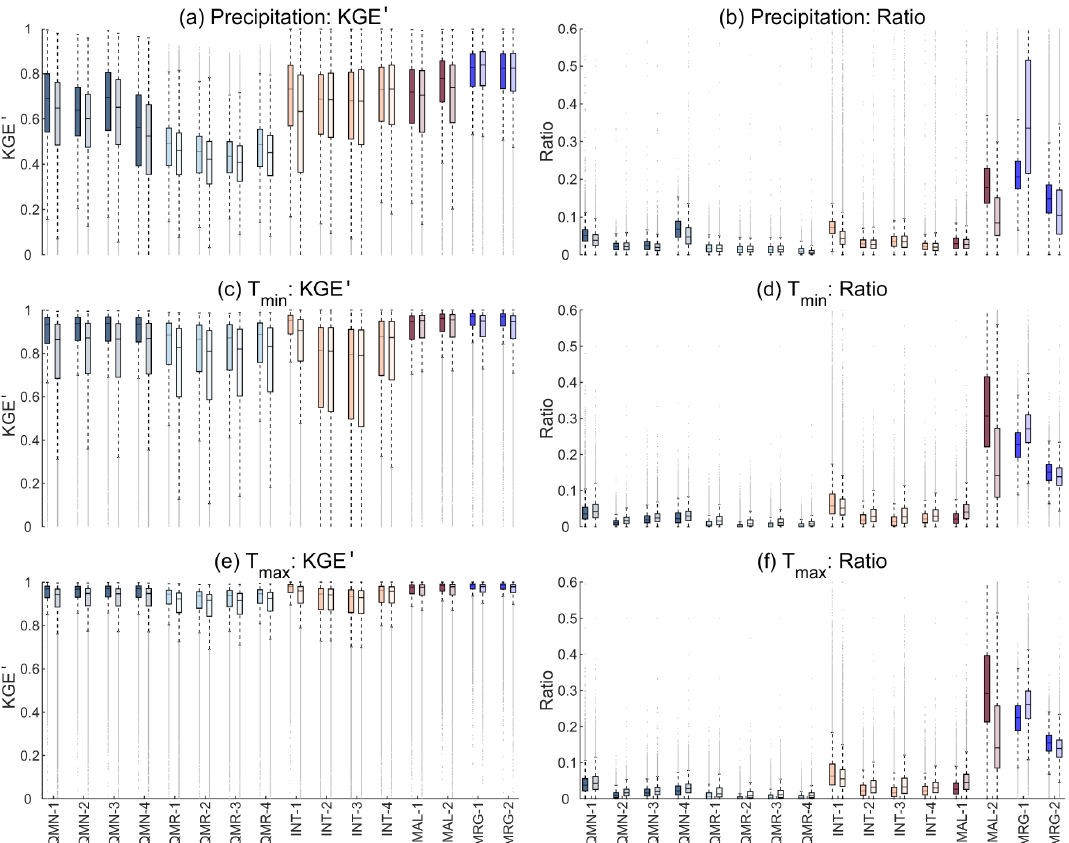
Figure 7. Boxplots of (a, c, e) KGE (cid:48) and (b, d, f) the contribution ratio of 16 strategies for all stations. Each strategy corresponds to two boxes in each panel; the left one with the darker color represents the observation period, and the right one with the lighter color represents the reconstruction period. The line within the box is the median. The upper and lower edges of the box represent the 25th and 75th percentiles, respectively. Values more than 1.5 times the interquartile range away from the upper or lower edges are outliers (dots).